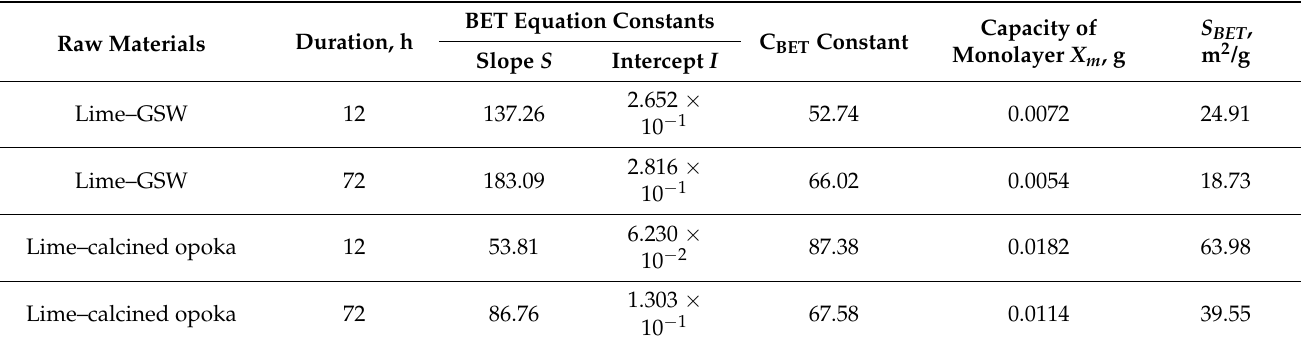
Table 3. Calculated parameters of synthesis products obtained from various raw materials. BET Equation Raw Materials Duration, h